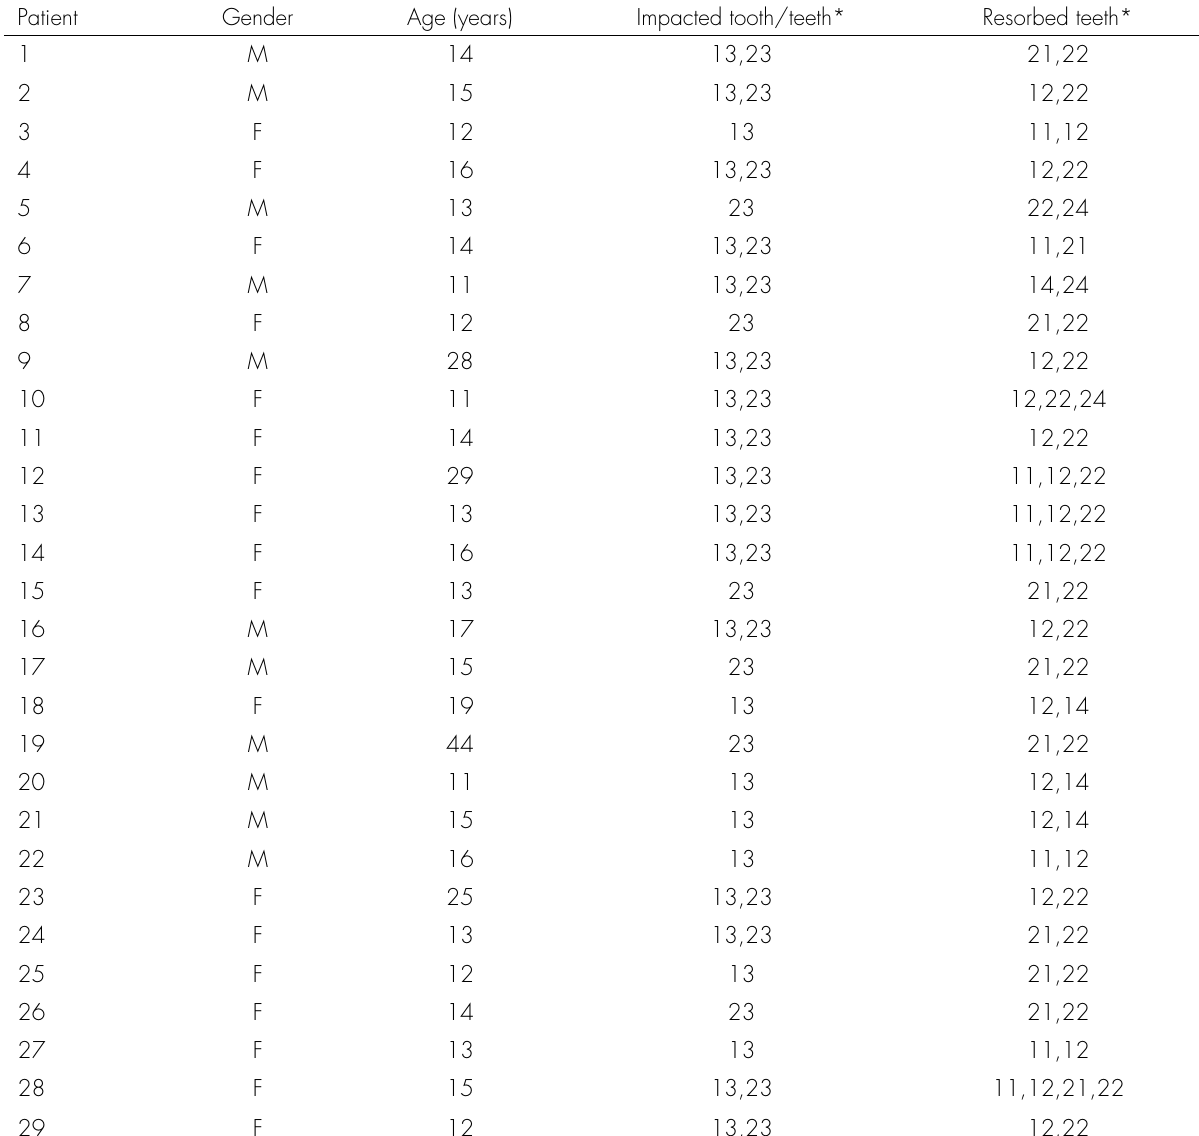
Table II. Demographics of subjects experiencing multiple resorbed